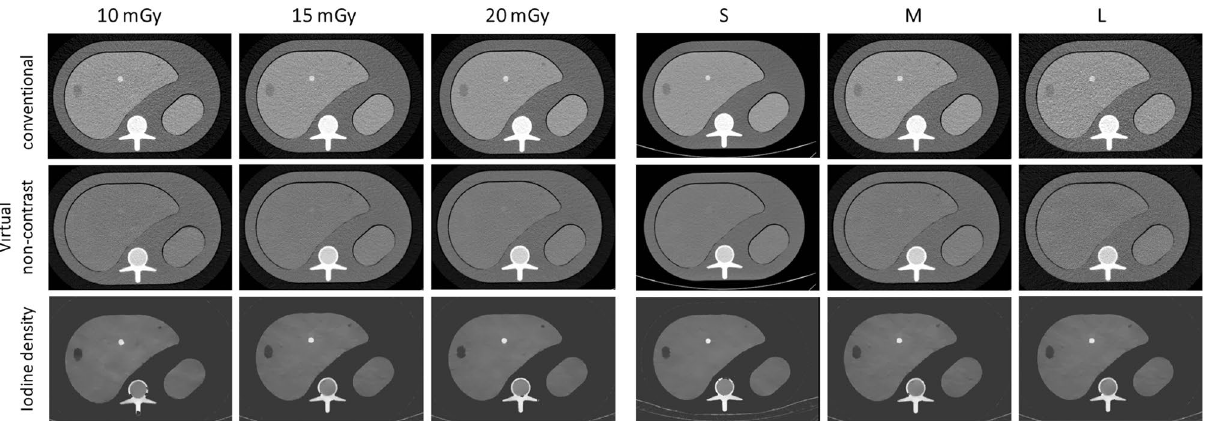
Figure 2. Example of axial slice images of liver lesions. Conventional (upper row), virtual non-contrast (middle row), and iodine density (lower row) images: LEFT) images of the medium sized phantom acquired with a CTDIvol of 10, 15, and 20 mGy are shown. RIGHT) images in different sizes (small, medium and large) are shown. Of note, conventional and VNC images are displayed with the institutional defaults for window level and width (WL 60, WW 360) and iodine (WL 2, WW 7), respectively. Images are cropped, hence the extension ring is not visible in S- and